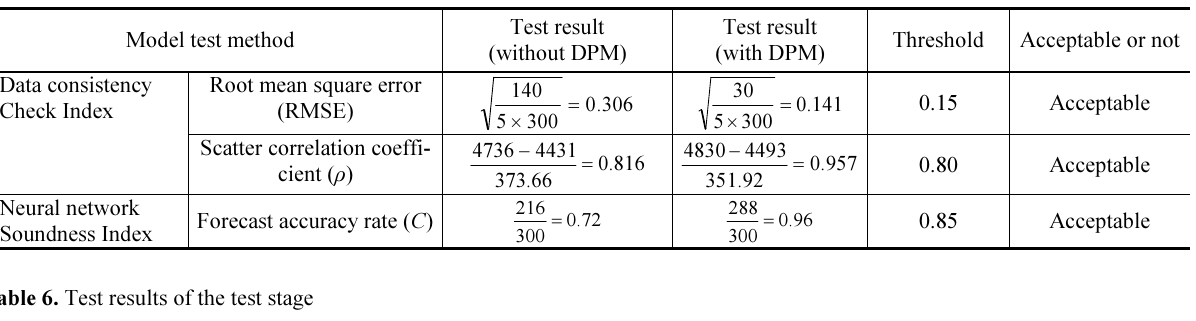
Table 5. Training results of the training stage